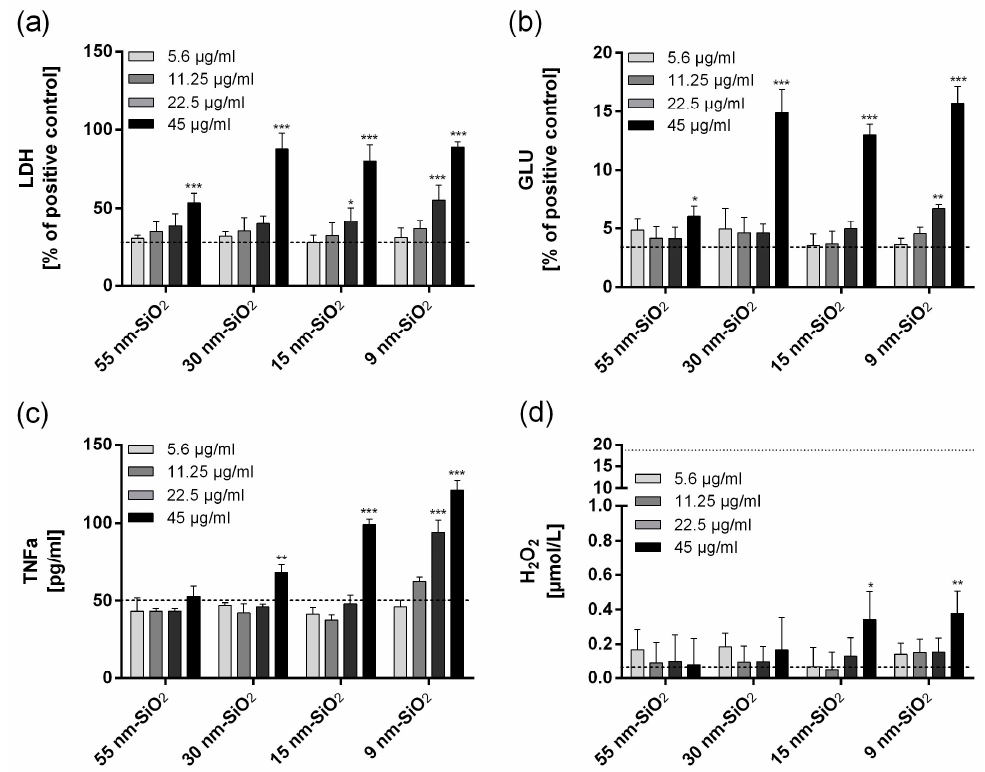
Figure 1. In vitro effects induced by 9 nm SiO 2 , 15 nm SiO 2 , 30 nm SiO 2 , and 55 nm SiO 2 in the NR8383 alveolar macrophage (AM) assay. Cell culture supernatants were assessed for ( a ) lactate dehydrogenase (LDH, expressed relative to the positive control, 0.1% Triton X-100); ( b ) β -glucuronidase (GLU, expressed relative to the positive control); ( c ) tumor necrosis factor alpha (TNF α ); and ( d ) H 2 O 2 . Values are expressed as means of three independent test runs ± standard deviation (* p -value ≤ 0.05; ** p -value ≤ 0.01; *** p -value ≤ 0.001). Levels of untreated vehicle control are indicated by dashed lines. For H 2 O 2 measurement, the level reached upon application of 180 µ g/mL zymosan (positive control) is indicated as a dotted line.